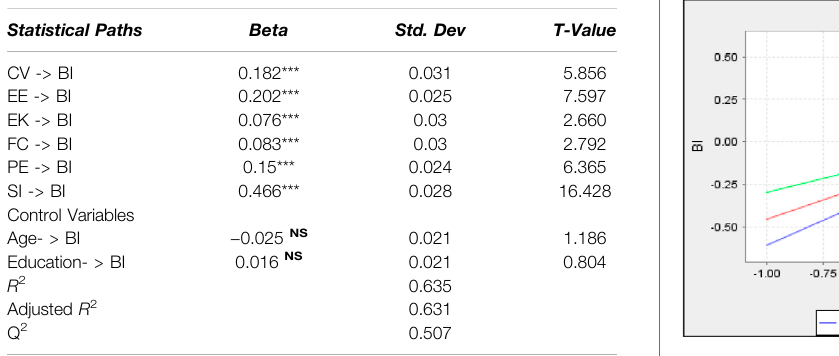
FIGURE 4 | Moderation effect (Slope) of Environmental Knowledge on SI- > BI.